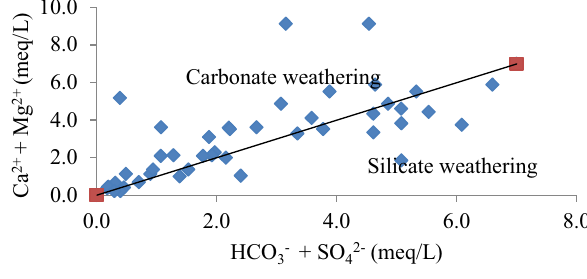
Fig. 6 Plot of Na + vs. Cl − for groundwater within the Asutifi-North district